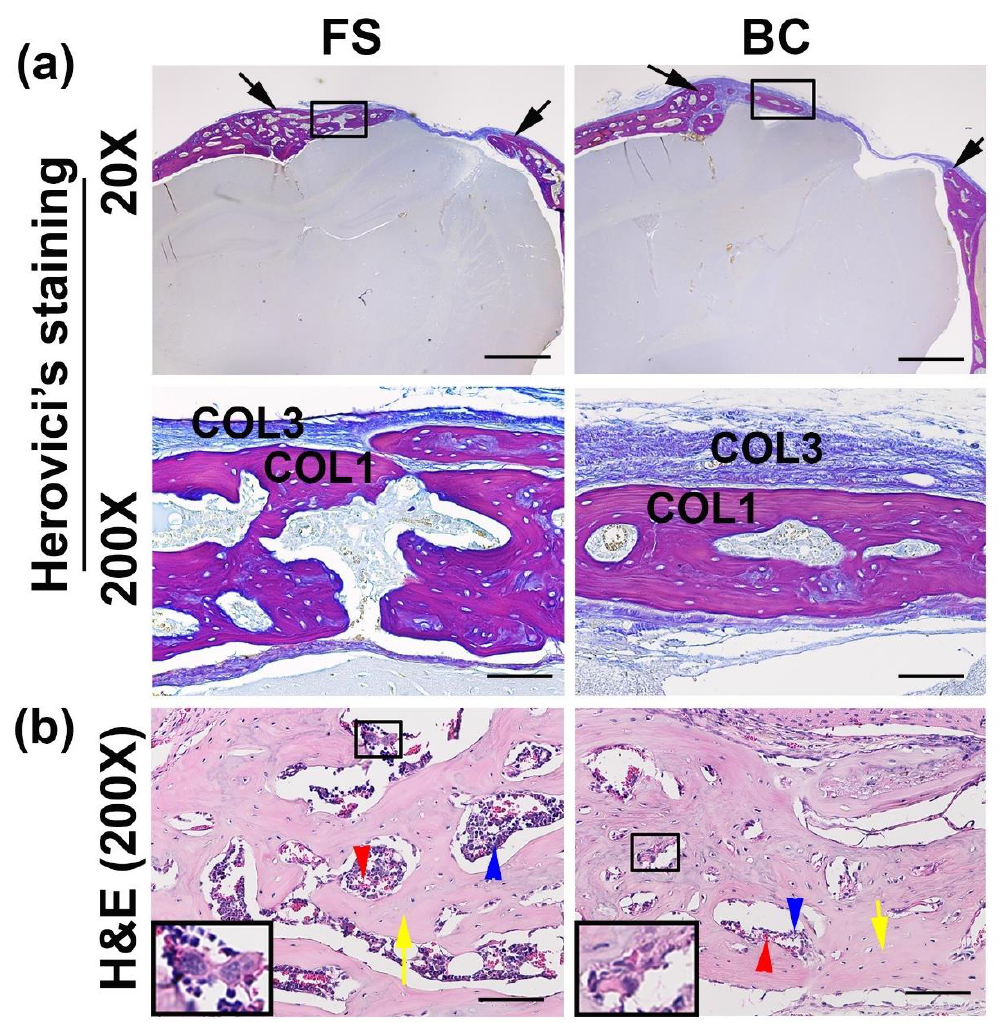
Figure 4. Histological analyses of the regenerated bone. ( a ) Herovici’s staining. The entire defect area is shown between the two black arrows in each image (top panels at 20×). Less collagen type I (red, COL1) matrix was found in the BC than in the FS group, in the defect area. Higher magnification (200×) showed the newly regenerated bone in the defect area (red, COL1). Fibrotic tissues are stained as blue fibers (COL3). ( b ) H&E staining showed that the newly regenerated bone was mainly trabecular bone and contained bone matrix (yellow arrows) and bone marrow that consisted of red blood cells (red arrows), hematopoietic cells (blue arrows), and megakaryocytes (insets). Scale bars = 1000 µm and 100 µm for 20× and 200× magnifications, respectively.